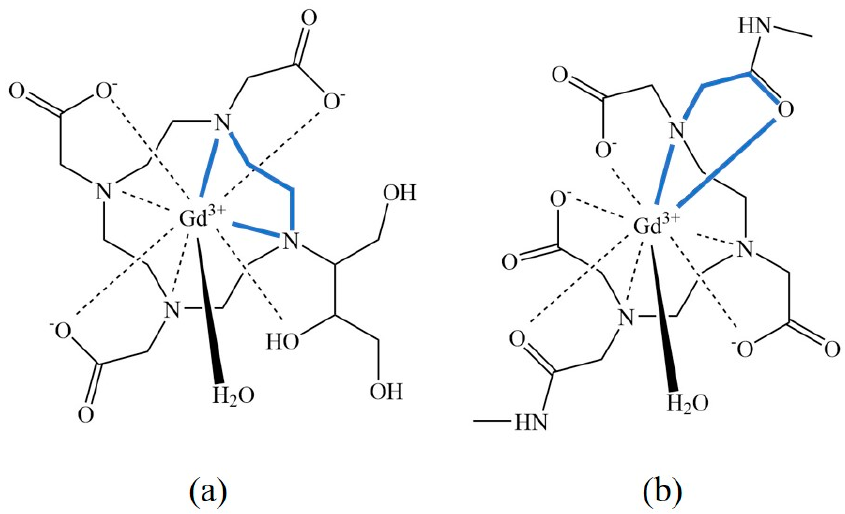
Figure 3. Structure of gadolinium chelates ( a ) Gadovist and ( b ) Omniscan, highlighting the two types of five-membered-rings formed between gadolinium with nitrogen and oxygen.